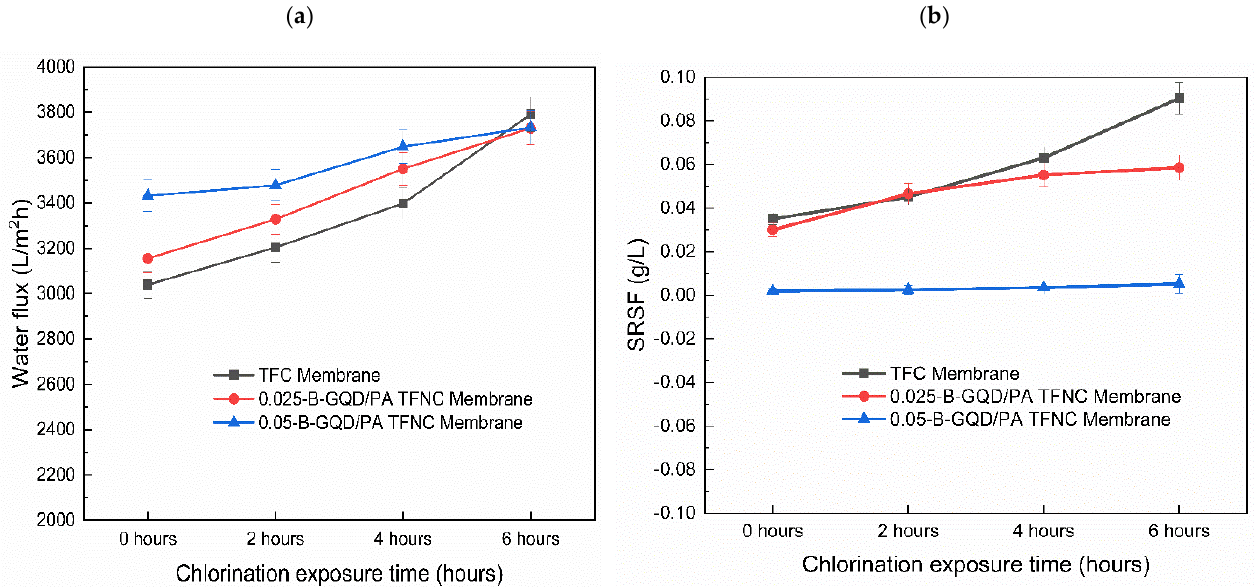
Figure 12. ( a ) Impact of chlorination conditions on the water flux of the TFC and TFNC membranes treated with a 1000 ppm NaOCl solution for 2–6 h at pH 5.5; ( b ) effect of chlorination conditions on the SRSF of TFC and the B-GQD TFNC membranes treated with a 1000 ppm NaOCl solution for 2–6 h at pH 5.5.